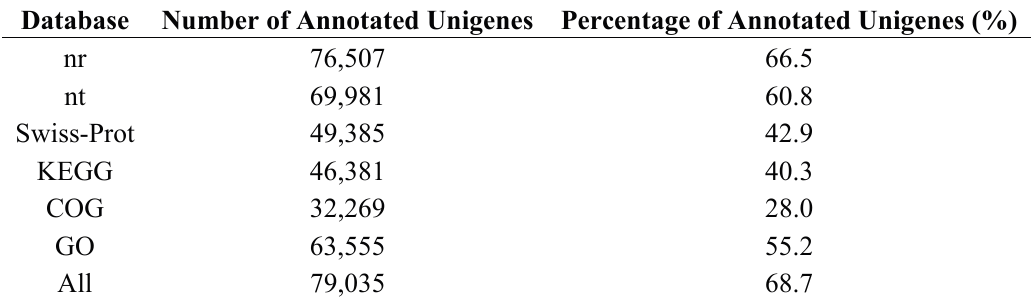
Table 2. Annotation of non-redundant unigenes of the transcriptome of P. fortunei .